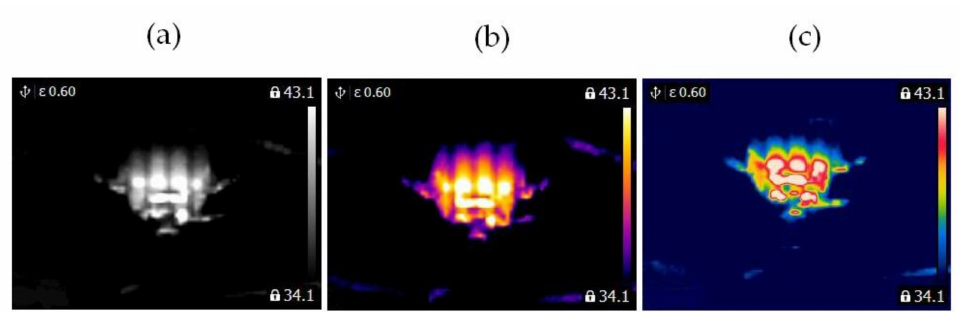
Figure 3. Blocked ventilation of the BLDC at 2100 rpm ( a ) gray-scale, ( b ) rainbow scale ( c ) photo.